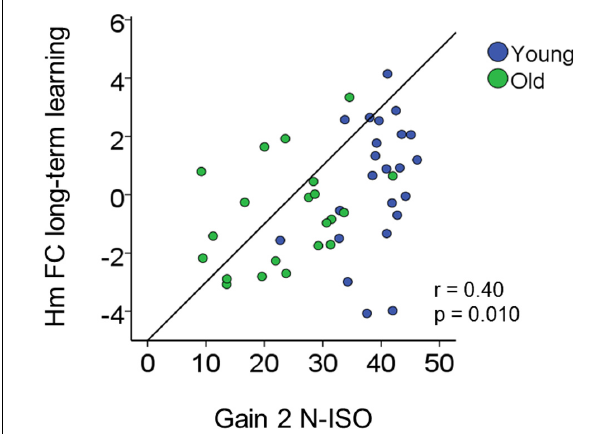
FIGURE 8 | Brain connectivity-behavior correlation. Scatter plot representing the significant correlation surviving Bonferroni correction ( p < 0.025)